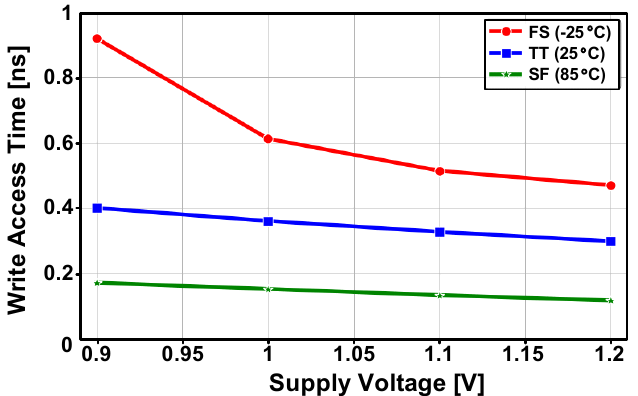
Figure 14. Post-layout simulated access time versus supply voltage with typical (TT 25 °C), best (SF 85 °C) and worst (FS − 25 °C) process corners and temperature conditions.